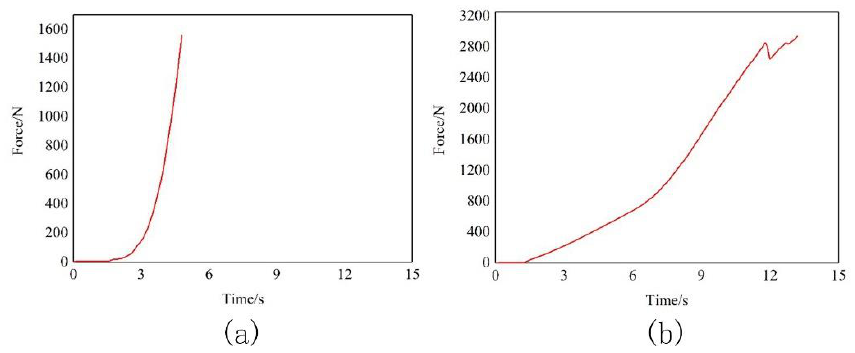
Figure 18. Force time history curve. ( a ) Freshwater, −40 °C, shear strength 1.086 MPa. ( b ) Qingdao seawater, −30 °C, shear strength 1.003 MPa.